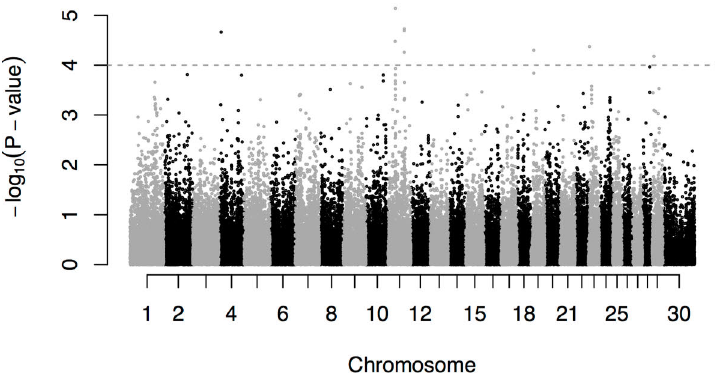
Fig 5. Association between individual SNP and milk yield from a genome-wide association study. Each dot represents a SNP that has passed the quality threshold and the high above the X axis is proportional to the strength of the association.